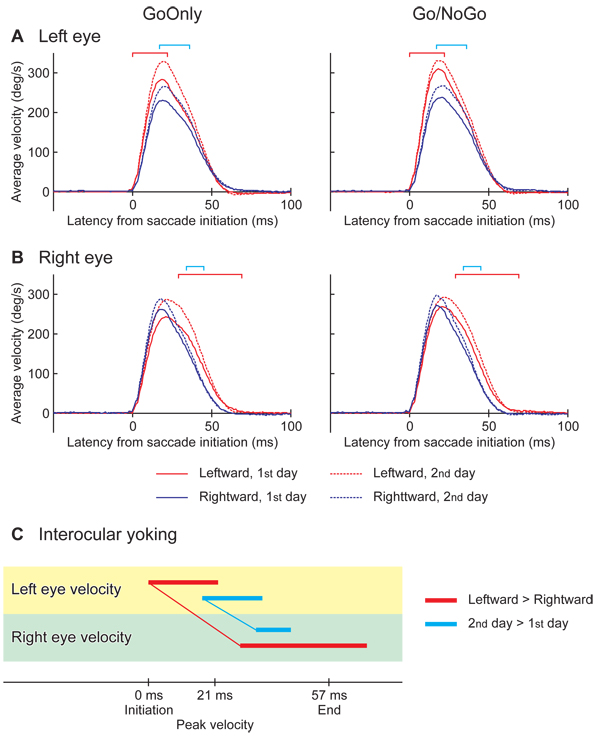
Dependence of averaged eye velocities on experimental conditions:A. Left eye; B. Right eye. Averages among all subjects are shown for the saccade toward the left (red lines) and right (blue lines) in the sessions of Go-Only (left panels) and Go/NoGo (right panels), on the 1st day (solid lines) and 2nd day (dashed lines). Positive deflections of velocity of eye movements toward saccadic target. Horizontal axes are the latency from the saccade initiation. The latencies of significantly faster movements are denoted by red square brackets for the leftward saccade relative to the rightward, and by cyan square brackets for the saccades on the 2nd day than 1st day. The significant differences were revealed by ANOVA factoring the saccade direction, the session type, the experiment day and the subject (p < 0.05 for 10 ms or more). C. Time courses comparisons between the eyes based on the significant differences. The latencies of significant difference with respect to the saccade directions are indicated by red horizontal bars. The onsets of the significant difference are linked between the eyes by a thin red line, showing eye yoking. Cyan horizontal bars linked by a thin line indicated the yoking found based on the significant day effect.